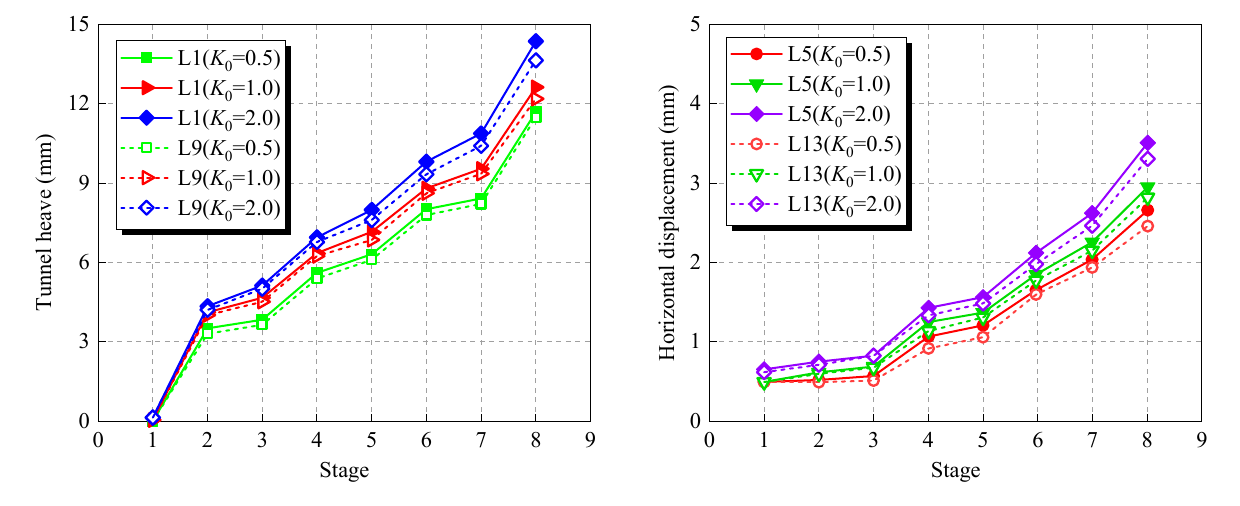
15 of 18 Figure 18. Influence of unloading ratio on tunnel displacement. 5.6. Effect of K 0 (Horizontal/Vertical Stress Ratio) It is well recognized that the coefficient of lateral pressure (the horizontal/vertical stress ratio, K 0 ) may lead to different mechanical responses of underground engineering structures [38,39]. In this section, the effect of varying K 0 values on tunnel displacement responses is examined, thereafter the K 0 values of 0.5, 1, and 2 are considered, with the tunnel and excavation geometries in prototype scale being modeled. The calculated tunnel heave and horizontal displacement at different stages with varying K 0 values are shown in Figure 19. This indicates that increasing the K 0 significantly increases the effect of the excavation on the tunnel displacements. At each K 0 , excavation-induced tunnel heave and horizontal displacement are both increased as the excavation proceeds, and the maximum values are obtained at the last stage, as expected. At each stage, the tunnel heave and